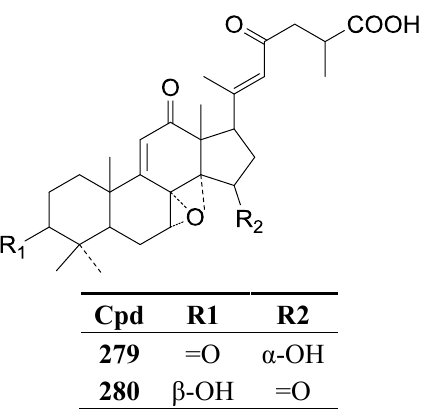
Figure 31. Structures of compounds 279 – 280 .